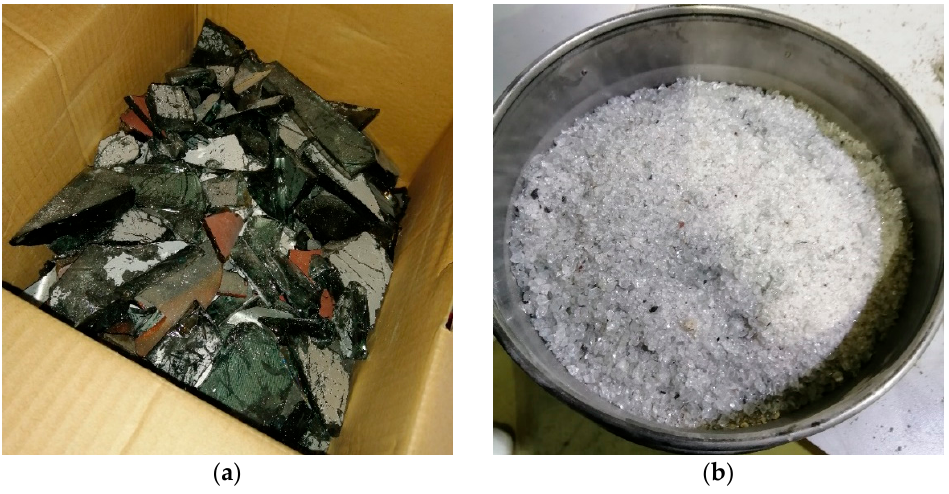
Figure 1. ( a ) CRT glass before crushing and ( b ) after crushing. Table 1. Details of concrete